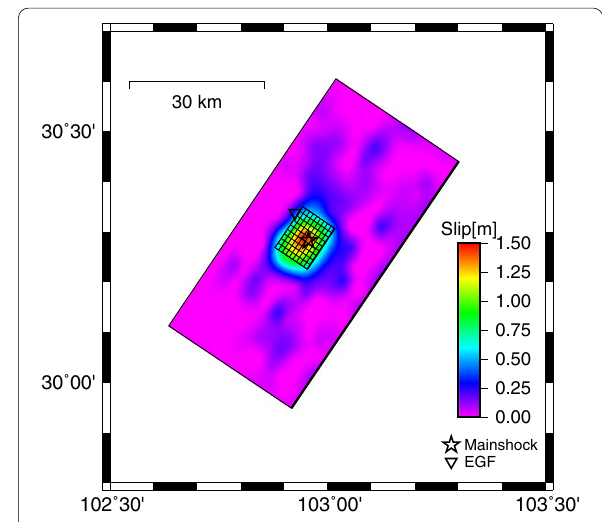
Fig. 3 Slip distribution of the kinematic source model (Li et al. 2017) drawn with colors and a rectangle of the best-fit SMGA of the characterized source model. The star and inverse triangle denote the epicenter of the mainshock and the EGF event,